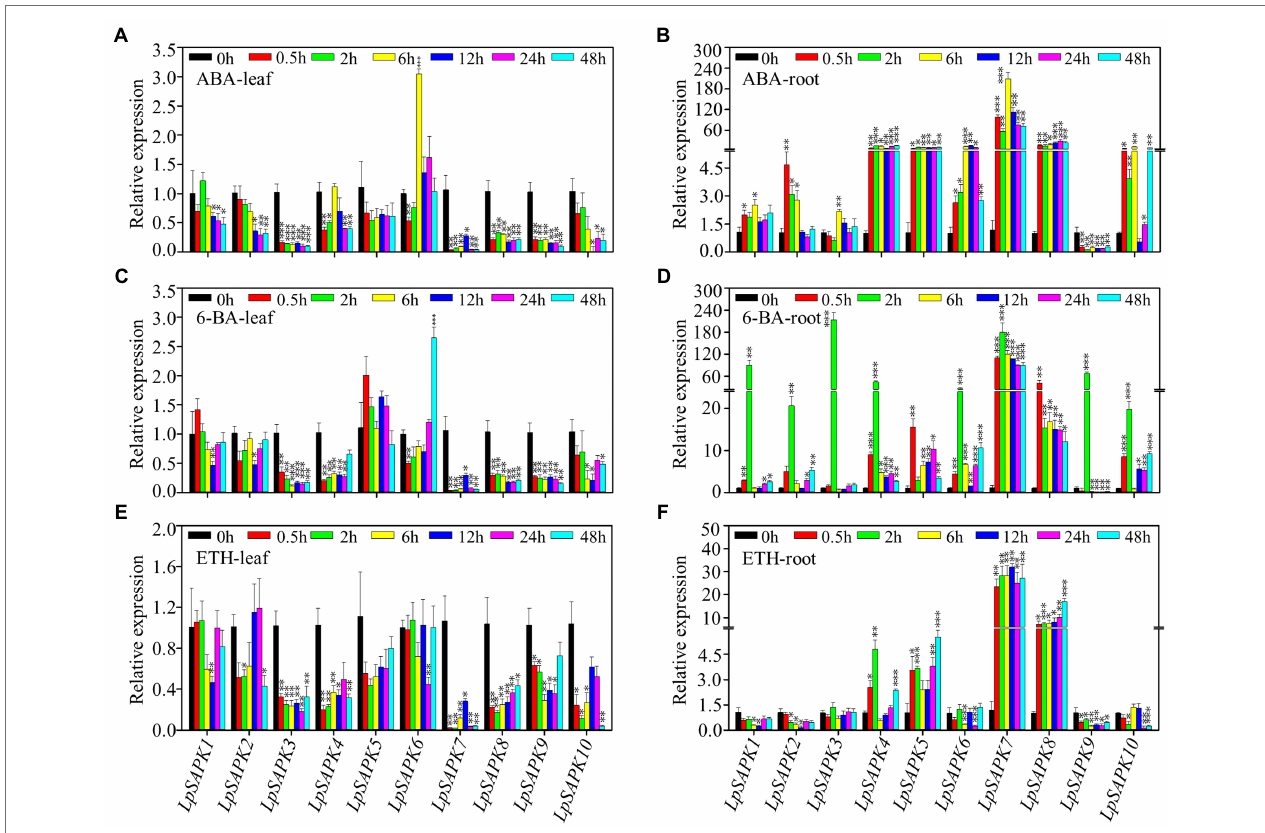
FIGURE 7 | Relative expression levels of LpSAPK s in leaves and roots under three hormone treatments. (A,B) ABA treatment; (C,D) cytokinin (6-BA) treatment; (E,F) ethephon treatment. Data are means ± SE ( n = 4). *, **, and *** above the bars represent significant differences compared to 0 h at p ≤ 0.05, 0.01, and 0.001,